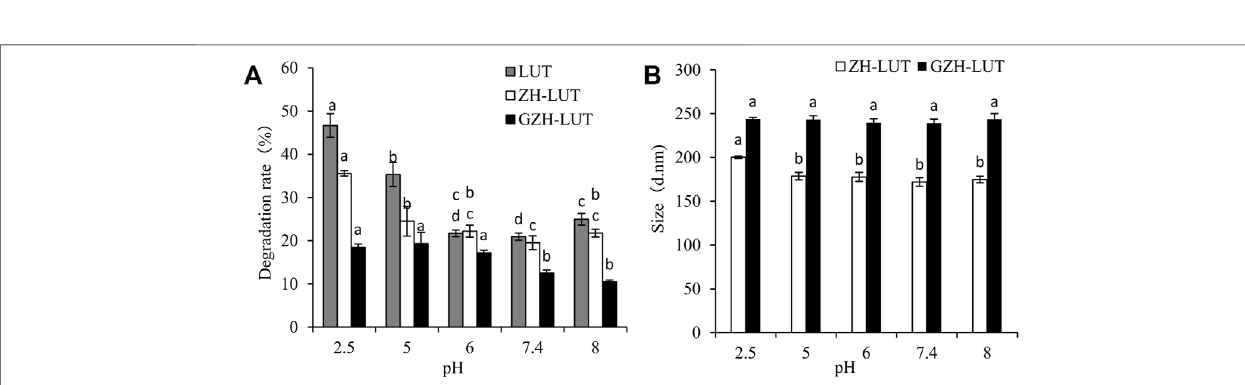
Frontiers in Pharmacology |